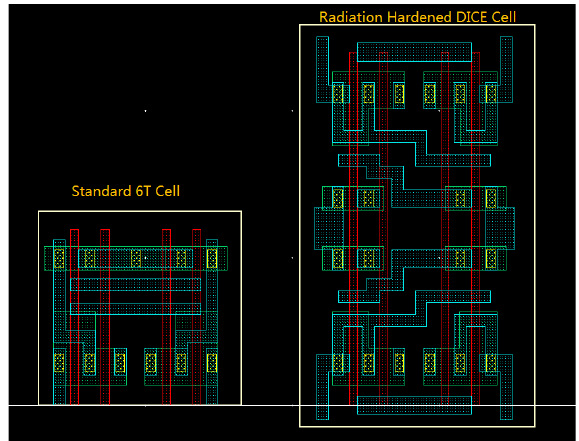
Figure 2. Layout comparison of the DICE hardened cell and standard 6-T cell.